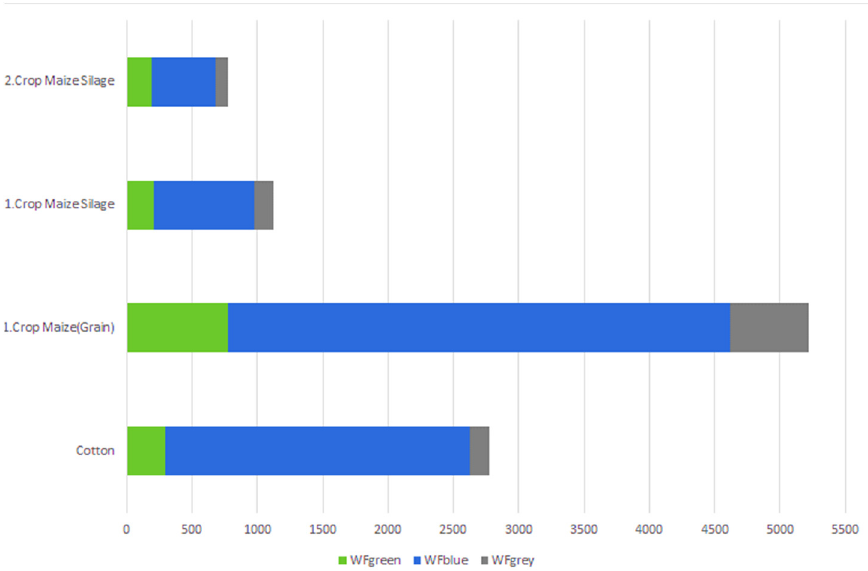
Figure 5. The total WF of all targeted